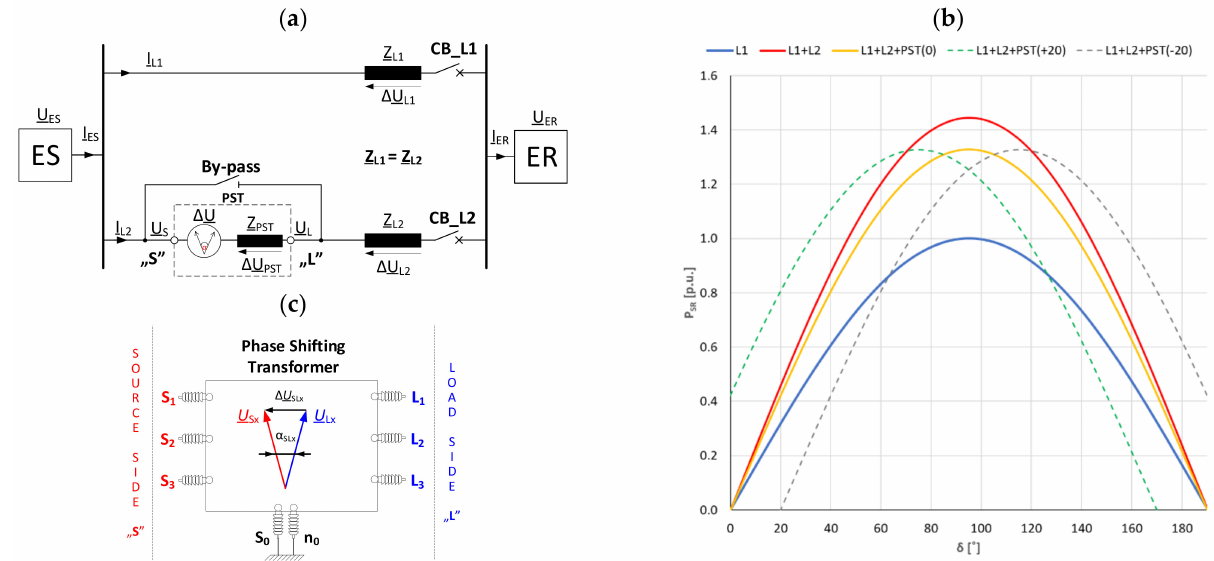
Figure 1. ( a ) Double infeed network example, ( b ) power diagram over the phase angle between ES and ER, ( c ) example of phase shifting transformer (PST) general